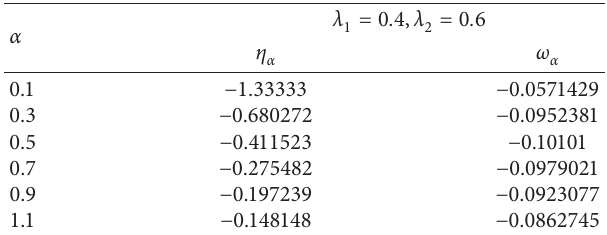
Table 5: Sensitivity and relativity sensitivity analysis of MTTF with